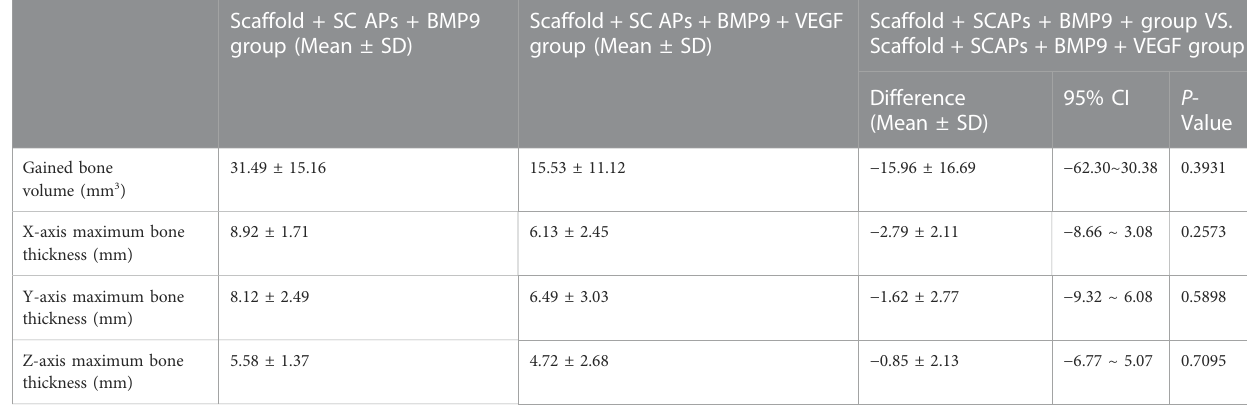
TABLE 3 Two independent samples t -test showed the mean deviation of the Scaffold + SCAPs + BMP9 group and the Scaffold + SCAPs + BMP9 + VEGF